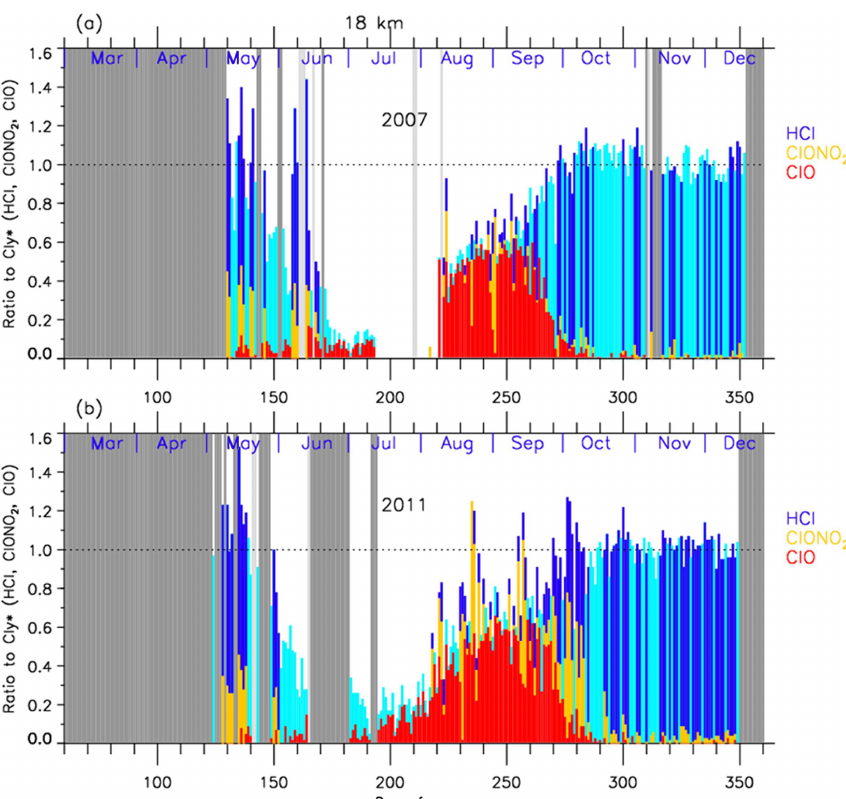
Figure 8. Time series of the ratios of HCl (dark blue or light blue), ClONO 2 (yellow), and ClO (red) to total chlorine (Cl ∗ y ) over Syowa Station at 18km in (a) 2007 and in (b) 2011. Light blue shows that either ClONO 2 or ClO data were missing on that day, while dark blue shows that all three data sets were available on that day. Shaded areas are the same as Fig.